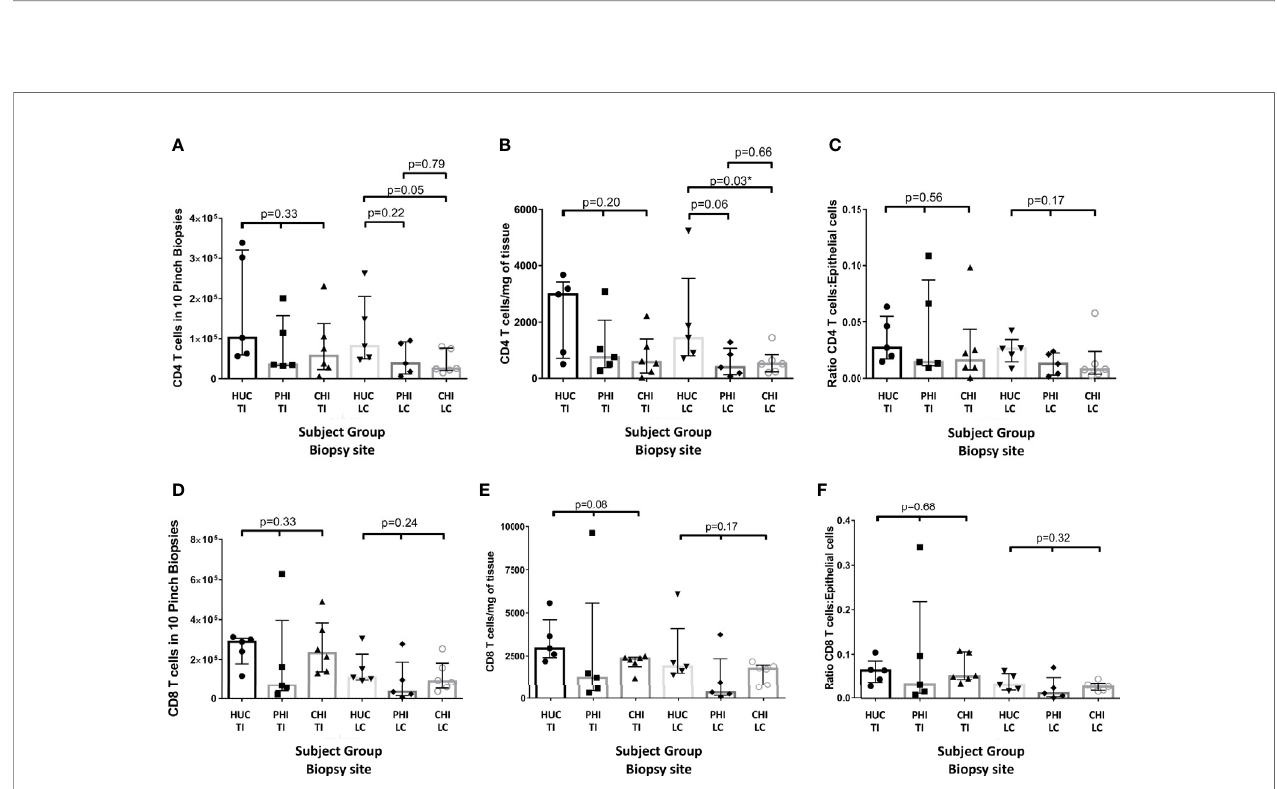
FIGURE 4 | Changes in CD4 panels (A – C) and CD8 (D – F) cell numbers in the terminal ileum and left colon between patient groups as: (A, D) an absolute count from ten biopsies; (B, E) standardised per milligram of tissue; and (C, F) standardized by epithelial cell number HUC, HIV-uninfected controls; PHI, HIV-positive patients treated during primary infection; CHI, HIV-positive patients treated during chronic infection; TI, terminal ileum; LC, left colon, *statistically signi fi cant (p ≤ 0.05). Statistical analysis was conducted using Kruskal Wallis one-way analysis of variance with pairwise post-hoc testing using Mann Whitney